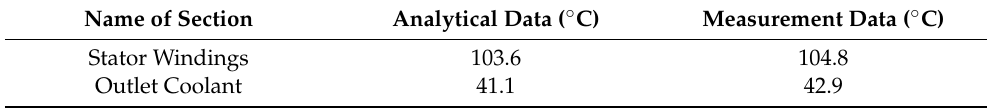
Table 4. Analytical and measurement